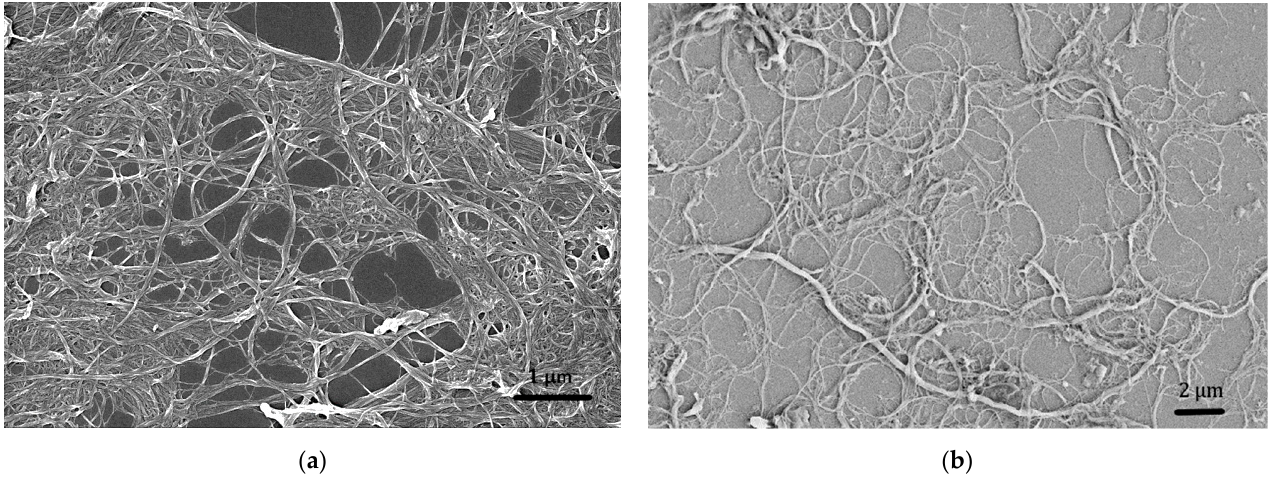
Figure 5. SEM images at different magnifications of a sample of new Celova produced by Weidmann, Switzerland with SE InLens ( a ) and normal SE ( b ) detector; bundles of cellulose fibres above 100 nm arise all over the sample.